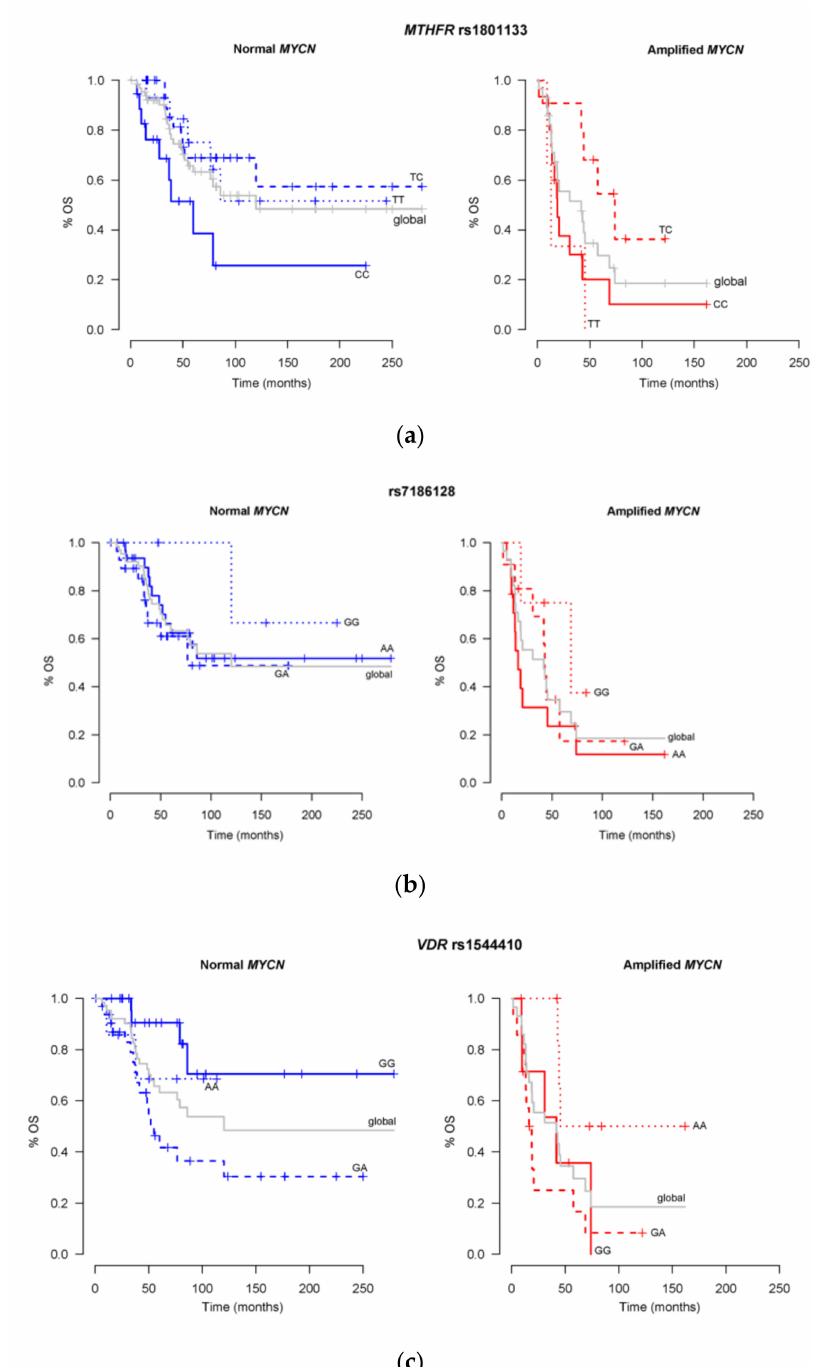
Figure 2. E ff ect of the addition of the OS related SNPs, selected by Cox regression and Elastic Net, to the OS prognosis e ff ect of MYCN status. The e ff ect of MYCN status alone (Normal, n = 66, on the left panels or Amplified, n = 29, on the right panels) is represented by the grey line named “global”, while the same patients’ data distributed according to the SNP variants, are represented by the colored lines. ( a ) Shows the results according to SNP variants in rs1801133 at MTHFR gene, with TC genotype achieving p = 0.02 statistically significant di ff erence comparing with the grey global lines. ( b ) shows the results according rs7186128 variants, with no statistical significance comparing with the global lines. ( c ) Shows the results according to SNP variants in rs1544410 at VDR gene, with GA genotype achieving p = 0.006 statistically significant di ff erence comparing with the global grey